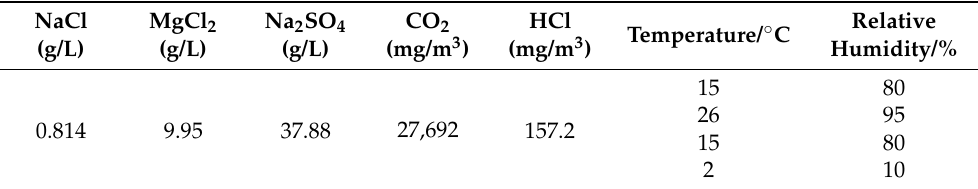
Table 3. Experiment parameters of acid–salt mist, carbon dioxide and periodic change of temperature and humidity.